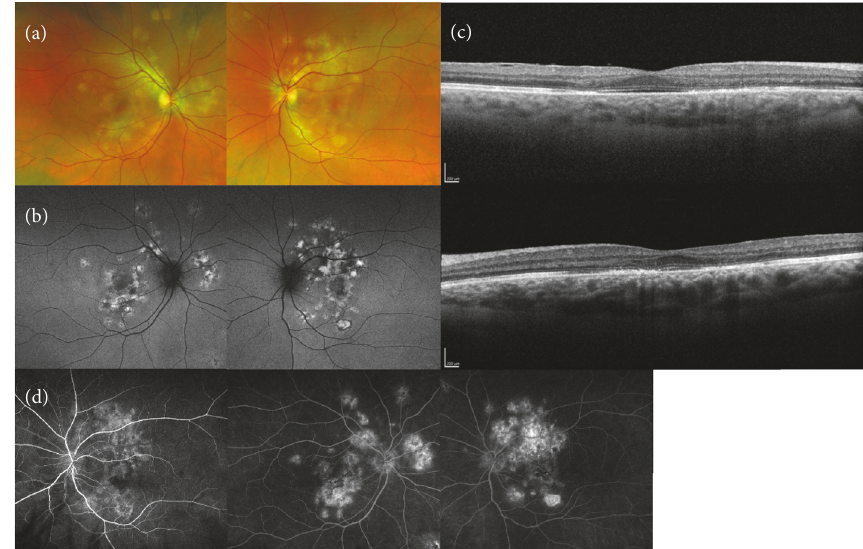
Figure 2: Images taken 3 months after onset of symptoms. Fundus photo, yellowish white subretinal placoid lesions smaller in size (a). FAF, placoid lesions with central hypoautofluorescence with hyperautofluorescent edges, smaller in size and boundaries less distinct (b). OCT Fovea,top: OD and bottom: OS. Muchimproved RPE and ellipsoid zone attenuationof placoid lesions and resolved subretinalhyperreflective material (c). FA, left: early phase OS. Central and right: late phase OD and OS. Early blocking with late staining less than before